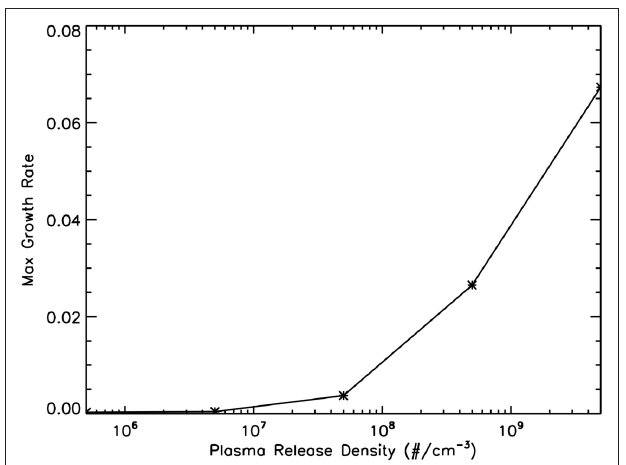
FIGURE 7 | Electron density (log 10 cm − 3 ) as a function of longitude and altitude at 0 ◦ latitude for two different simulations (Left and Right) at two different times (Top and Bottom) . The left panels show the time evolution for the background simulation with a density depletion, but no plasma release; in this case ESF develops after several hours. The right panels show the case where a plasma release is simulated at 200 km altitude and 9.9 ◦ latitude. Note that the plasma release is not visible in this picture because it is at a different latitude. As shown in Figure 2 the plasma spreads along the field line and then drifts downward. The bottom right panel shows that no ESF bubbles develop, even after several hours, as a result of the plasma release.